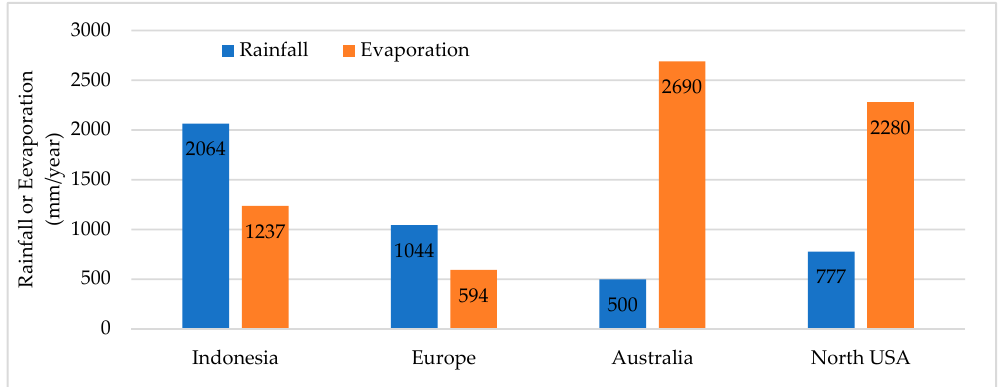
Figure 15. Average annual rainfall and evaporation.